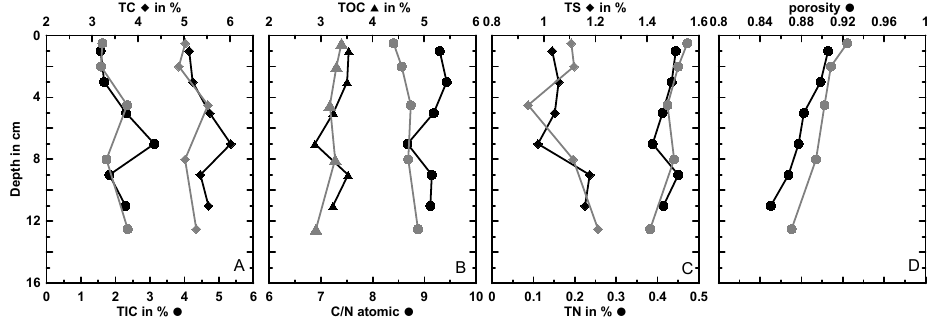
Figure 8. Sediment solid-phase parameters measured in the sediment of the ex situ replicate SO206-31 (MUC) core (grey lines and symbols) compared to the NHFC (originally LFC, black lines and symbols). Total carbon content (TC, diamonds) and total inorganic carbon content (TIC, circles) in drywt.% (a) , atomic C / N ratio (circle) and total organic carbon content (TOC, triangles) in drywt.% (b) , total nitrogen (TN, diamonds) and total sulfur (TS, circles) in drywt.% (c) , and porosity of the sediment (d) .